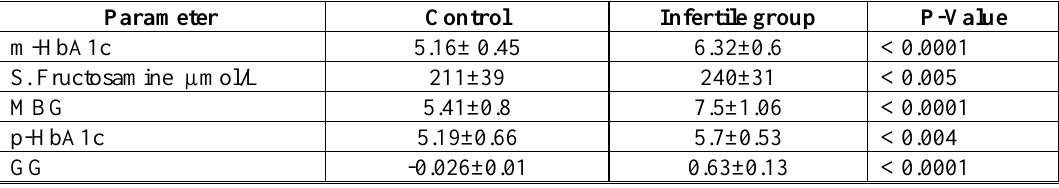
Table 1. Glycosylation profile in young infertile male in compare to healthy controls Parameter Control Infertile